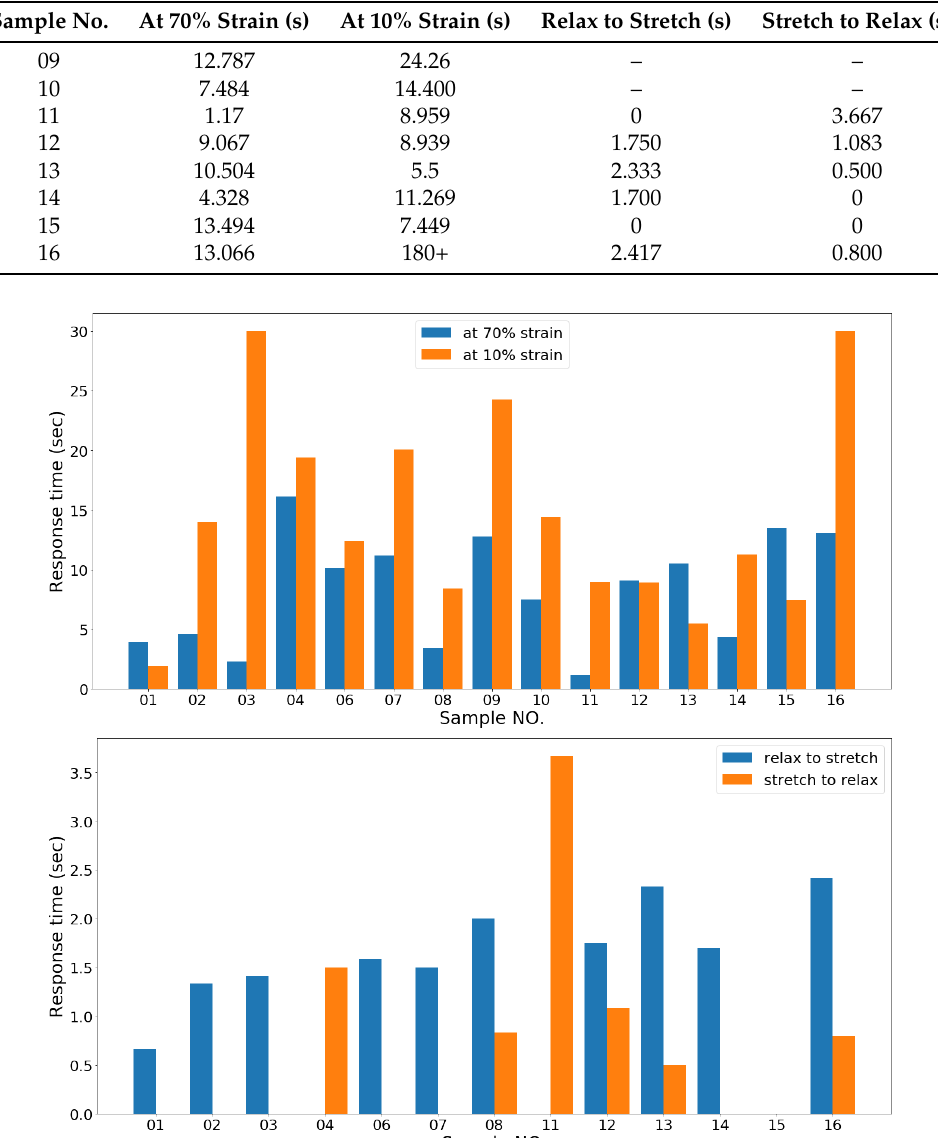
Figure 12. Comparison of each sensor‘s response time in static ( top ) and dynamic ( bottom )